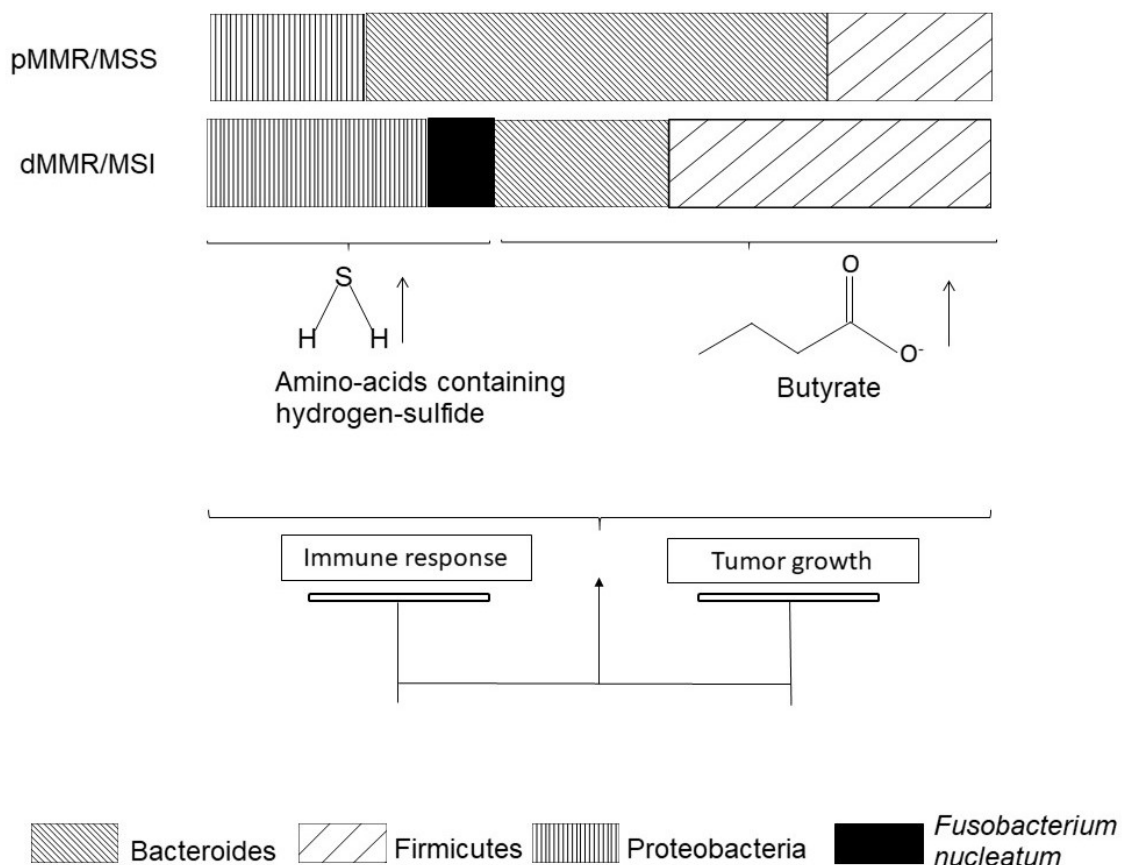
Figure 3. pMMR/MSS colorectal cancers and dMMR/MSI colorectal cancers have different microbiota.